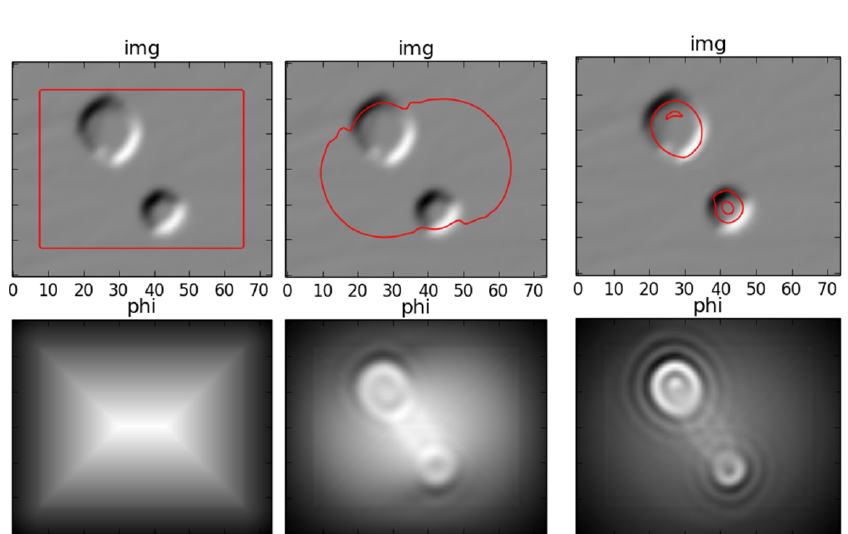
Figure 3. Level-set evolution for the detection of sinkholes. Right to left: initialization, evolution, and final results; Top: the level-set contour; Bottom: the level-set